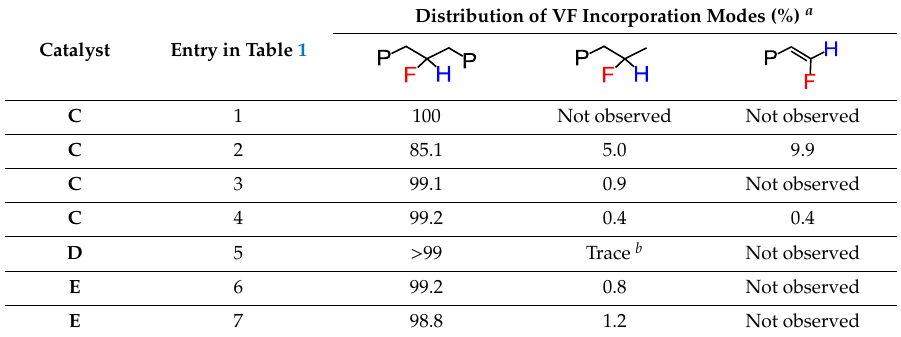
Table 2. Microstructures of E / VF copolymers produced by catalysts C , D, and E [41–47] . Table 2. Microstructures of E/VF copolymers produced by catalysts C , D, and E Table 2. Microstructures of E/VF copolymers produced by catalysts C , D, and E [41–47]. Table 2. Microstructures of E/VF copolymers produced by catalysts C , D, and E [41–47]. Table 2. Microstructures of E/VF copolymers produced by catalysts C , D, and E [41–47]. Catalyst Catalyst